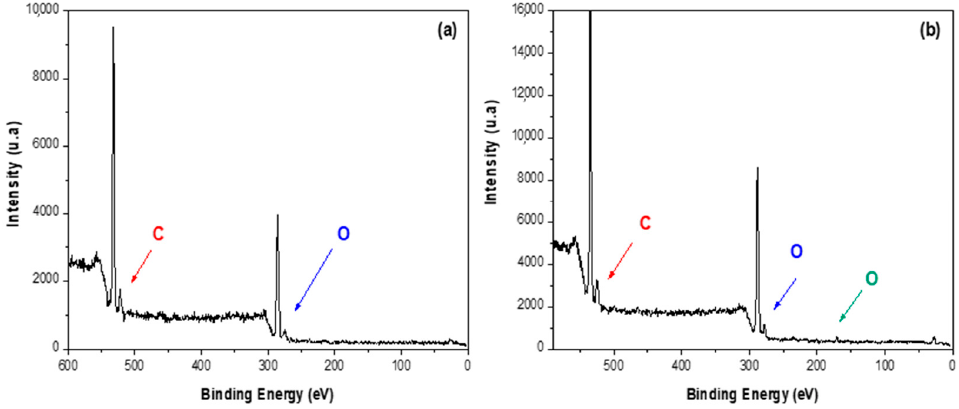
Figure 2. XPS spectrum of ( a ) soluble-grade cellulose pulp, and ( b ) CNC-S (E8S).